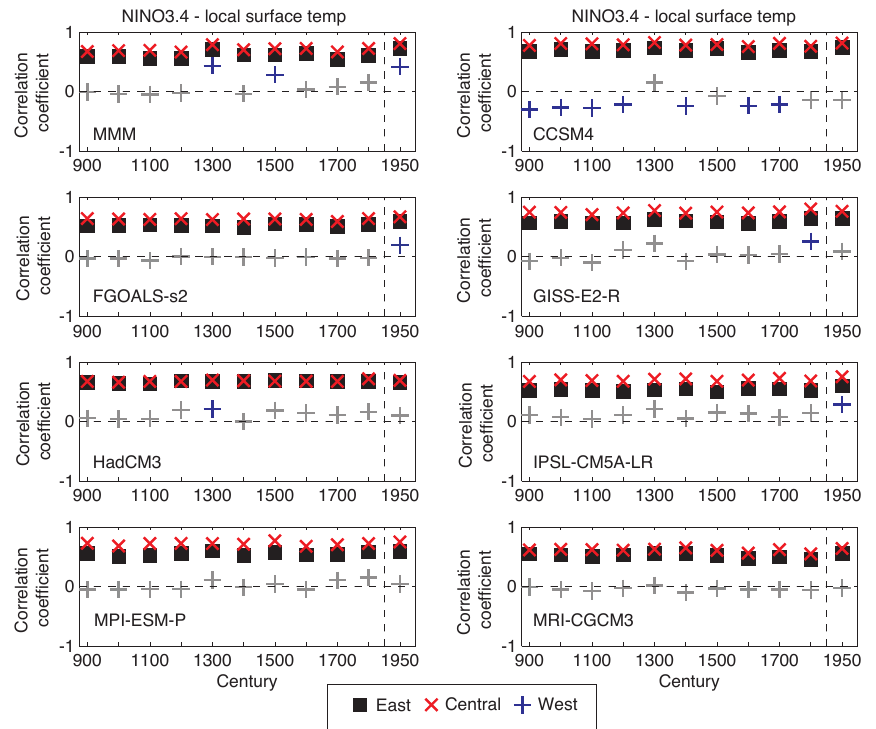
Figure 7. Area-mean correlation coefficients ( R ) of NINO3.4 and local surface air temperature for the East (black square), Central (red cross) and West (blue cross) calculated for the MMM, and for each model. Data points show correlation coefficients calculated for ten 100-year epochs comprising the Last Millennium simulation and for the historical simulation (1906–2005). Plot markers in grey indicate correlations that are not statistically significant (at the 5% significance